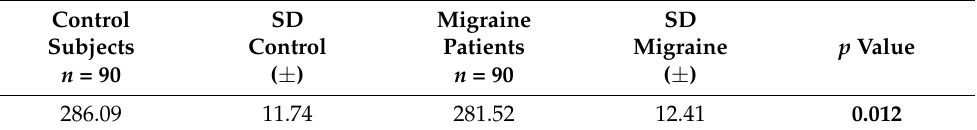
Table 2. Average macular thickness ( µ